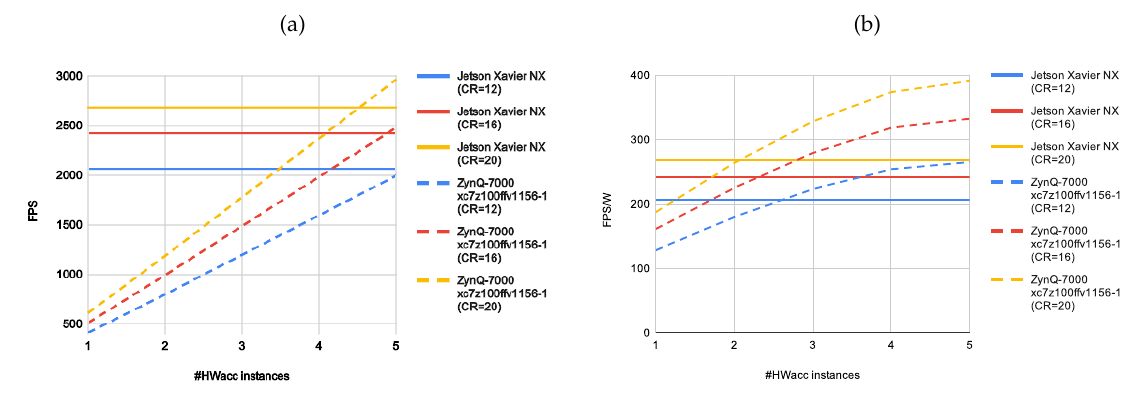
Figure 15. Evolution of the performance ( a ) and energy efficiency ( b ) of a multi-core version of the FPGA-based HyperLCA computing platform. Comparison with the GPU-based implementation model described in [29] performed onto NVIDIA Jetson Xavier NX ( N bits = 8, BS = 1024, using a Xilinx Zynq-7000